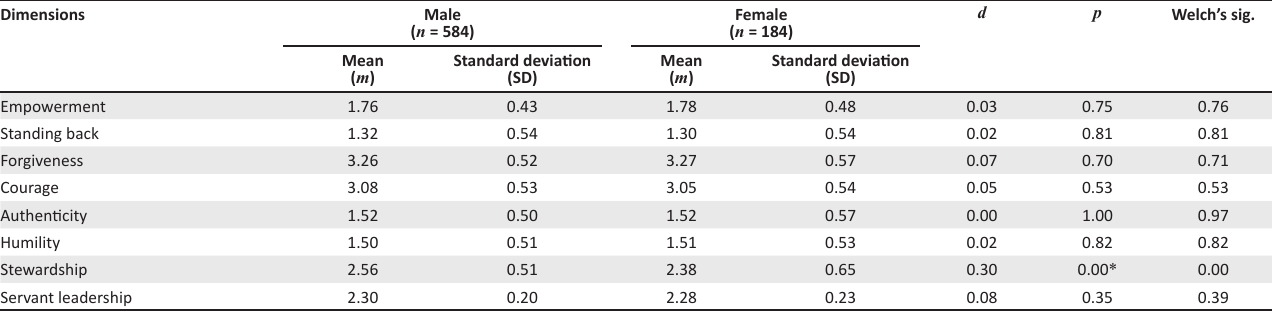
TABLE 4: Servant leadership recordings for gender groups.